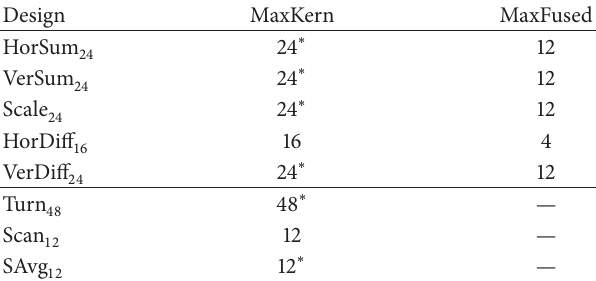
Table 2: Unrolling factors 𝑓 𝑢 of synthesized kernels. Asterisks ( ∗ ) mark unrolling that suffices to reach bandwidth limits. MaxKern denotes individual kernels; MaxFused denotes the integrated aggre- gation design; for the scanline phase, the same individual kernels are used.